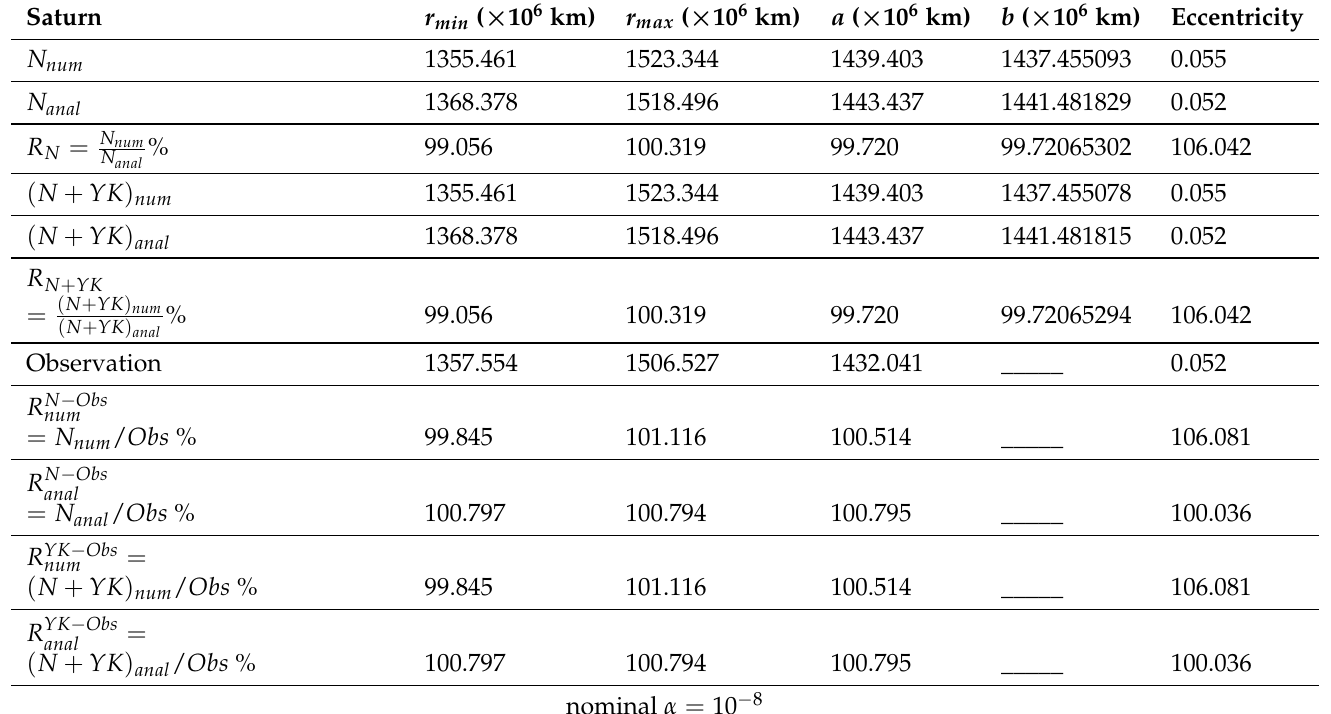
Table A11. The values of the calculated and observational astronomical parameters, for nominal α , of the planet Saturn, whose number of moons is